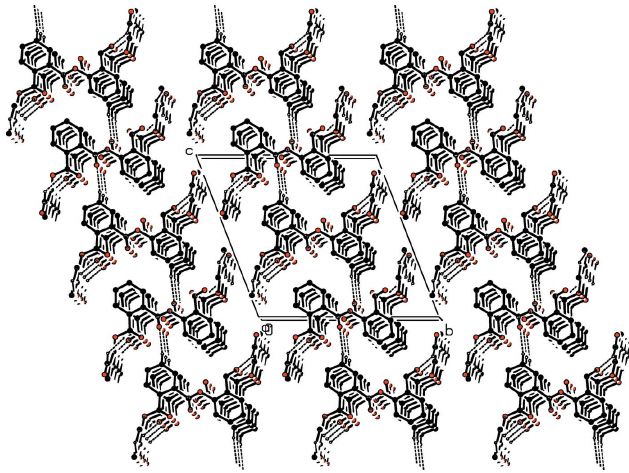
Figure 2 A packing diagram viewed along the a axis, showing the C—H (cid:3)(cid:3)(cid:3) O hydrogen bonds (dashed